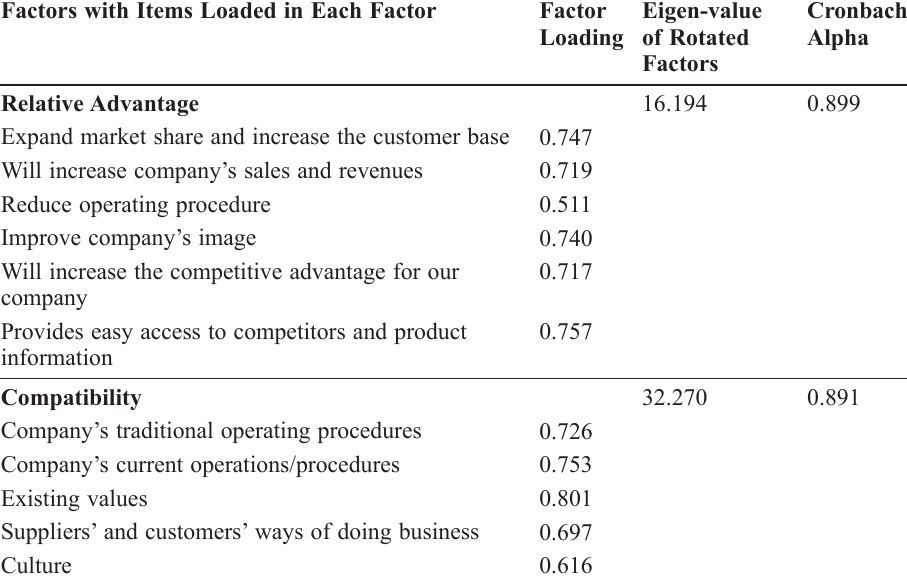
Table 2. Results of Factor and Reliability